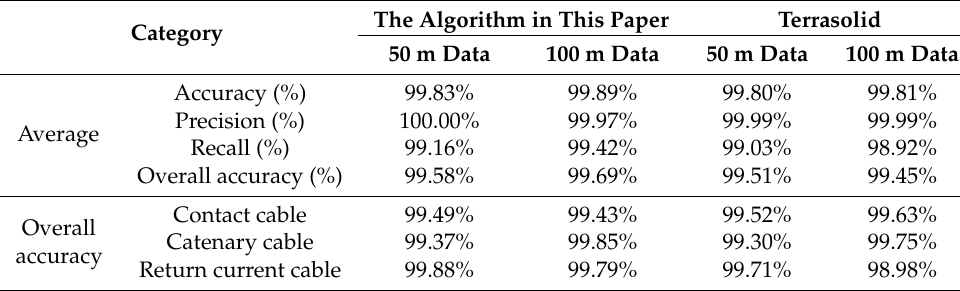
Table 7. Accuracy comparison of the two